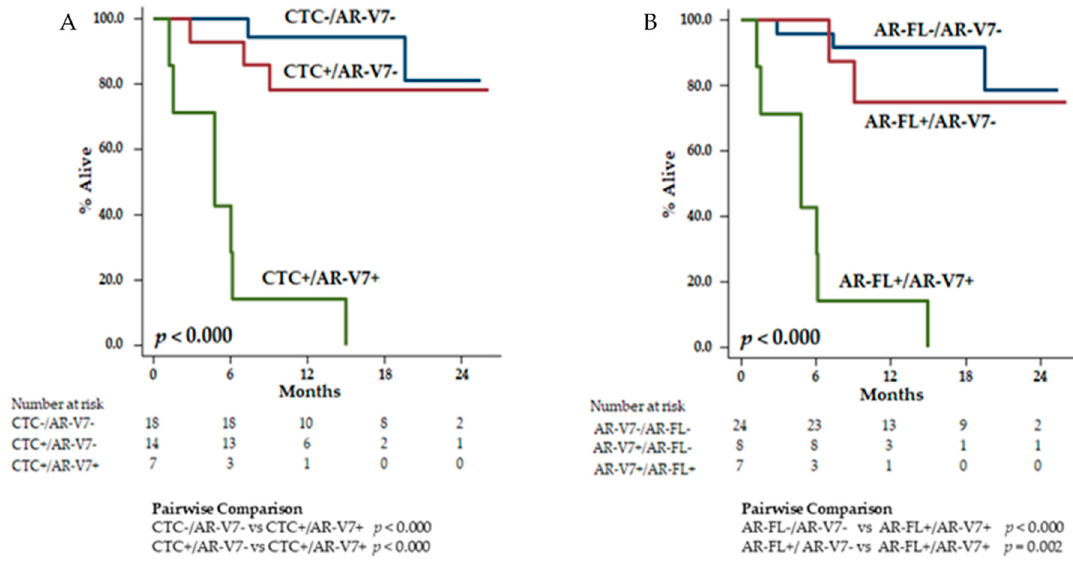
Figure 4. Prognostic nomograms according to combinations of CTC with AR-V7 ( A ) and AR-FL with AR-V7 ( B ).